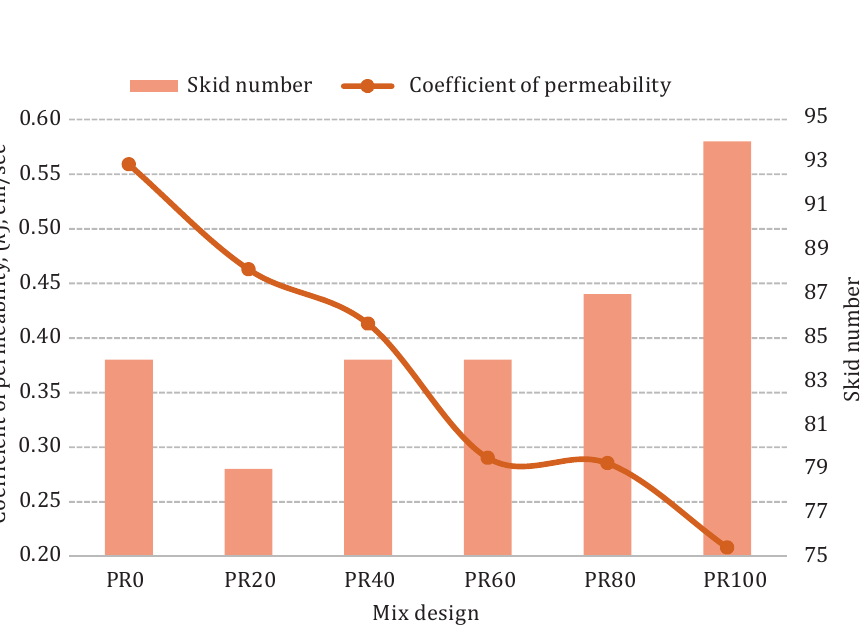
Figure 7. Influence of addition of RCA on the permeability and skid resistance of porous